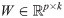
Pipeline for estimating networks, factor loadings, and predictive model for biological brain age.Inferred factors W∈Rp×k describe networks which are reproducible across the entire population, the subject-specific factor loadings gl(i) are then used to predict brain age. Once the factor loadings are estimated as above, using one experimental data-set (we use CamCAN data in our experiments), we can then assess how these factors perform for brain age prediction on completely held-out data-sets; we demonstrate how the model generalizes well using HCP and ATR Wide-Age-Range datasets.